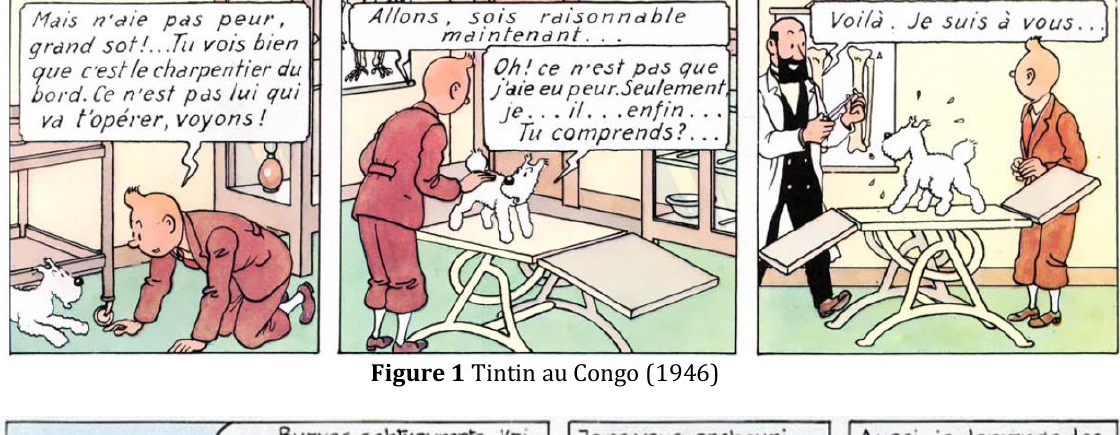
Figure 1 Tintin au Congo (1946)